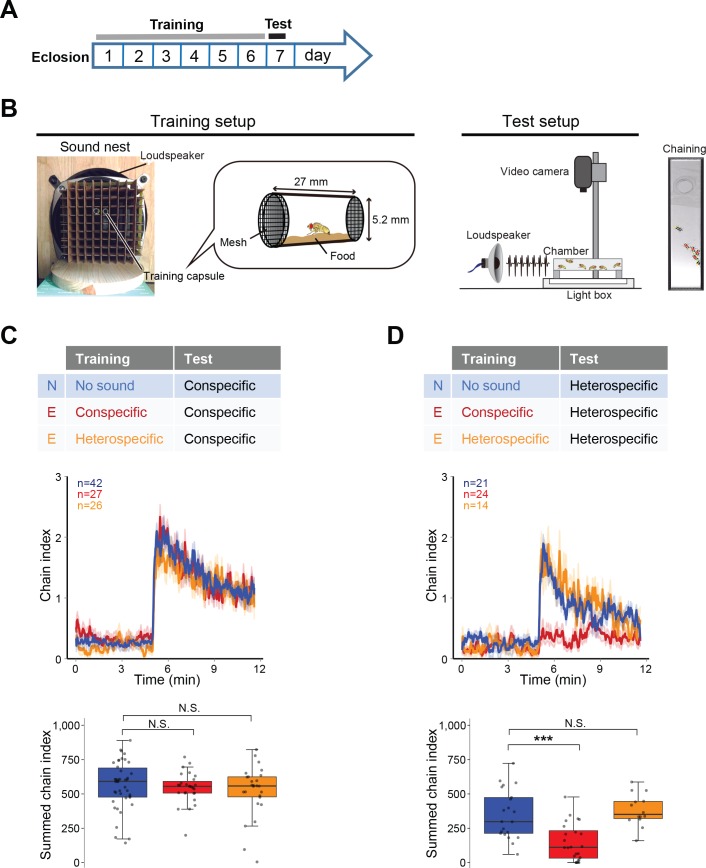
Fine-tuned song response of males after the training.(A) Protocol for the training and test sessions. (B) Setup for the training and chaining test. In the training session, single-housed male flies were exposed to a training song for the first 6 days after eclosion. In the test session, song was delivered from a loudspeaker. Appropriate song typically drove the male flies to form male-male chains (chaining). Males in a chain are marked with red dots. (C, D) Chaining response to the conspecific song (C) or heterospecific song (D) after training. N, naïve group with no sound training (blue); E, experienced group with conspecific song training (red) or heterospecific song training (orange). The way to show the time courses of chaining behavior and the boxplot is similar to that depicted in Figure 1. N.S., not significant, p>0.05; ***p<0.001; Mann-Whitney U test versus naïve group.